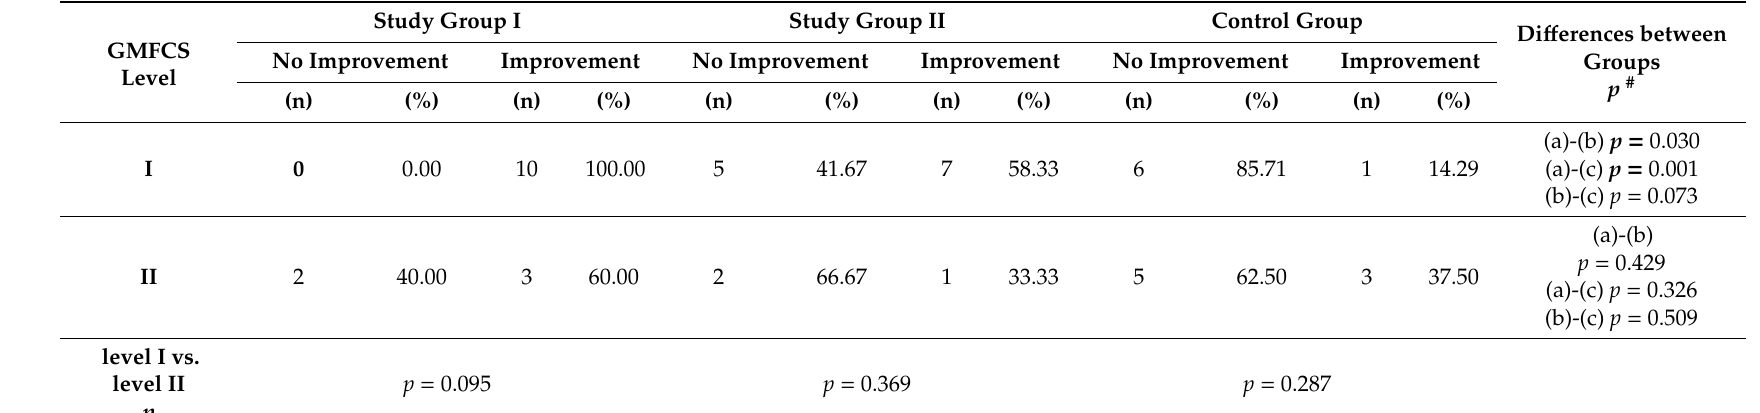
Table 4. Changes in the SAS scale assessment for the GMFCS